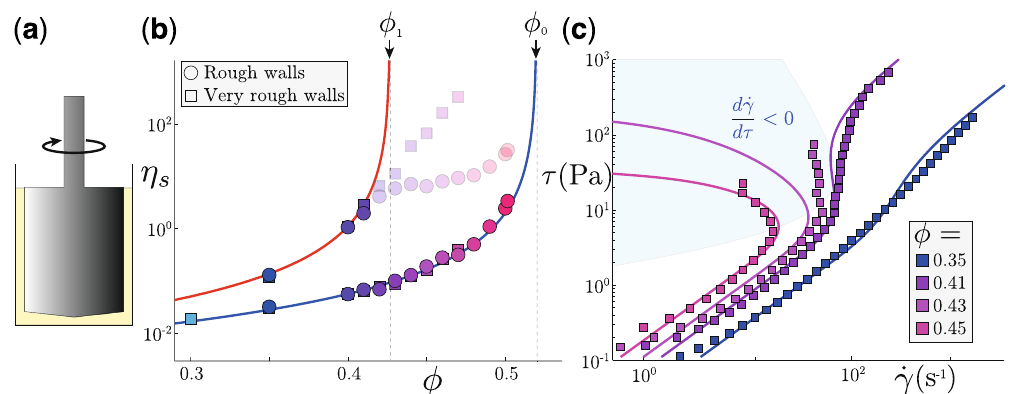
Fig. 5 Rheological data fi tting procedure. a Cylindrical-Couette geometry used to characterize the rheology of the aqueous suspension of cornstarch (yellow). The gray area represents the cylinder rotating in the direction indicated by the black arrow. b Viscosity (Pa.s) below ( τ ≪ τ * ) and above ( τ ≫ τ * ) the shear-thickening transition versus ϕ . Blue-solid-line: frictionless branch, red-solid-line: frictional branch, black-dashed-lines: jamming volume fractions for the frictionless and frictional branches de fi ning ϕ 0 and ϕ 1 , respectively. Square and circle symbols correspond to measurements performed with different wall roughness. The data points made transparent are not used in the fi tting procedure as for these points, the measurement depend on the wall roughness. c Shear stress τ versus shear rate _ γ measured at various volume fraction ϕ . Solid lines: Wyart & Cates rheological laws. The blue shaded area highlights the region where the rheograms are negatively sloped (d _ γ = d τ < Couette cell (Fig. 5a) using a rheometer (Anton Paar MCR 501). The height of the shear-cell (40 mm) is suf fi ciently large to neglect sedimentation effects of the particles during the measurement. Similarly to the procedure followed by Guy et al. 4 , the viscosity below ( τ ≪ τ * ) and above ( τ ≫ τ * ) the shear-thickening tran- sition are extracted and plotted versus ϕ (Fig. 5b). The low viscosity branch (frictionless branch) is fi rst fi tted with η ð ϕ Þ ¼ η s ð ϕ 0 (cid:3) ϕ Þ (cid:3) 2 , with η s and ϕ 0 as = 0.91± 0.01 mPa.s and ϕ = 0.52± 0.005. The fi tting parameters. This yields η s 0 large viscosity branch (frictional branch) is then fi tted with η ð ϕ Þ ¼ η s ð ϕ 1 (cid:3) ϕ Þ (cid:3) 2 , using the previous estimation of η s , and letting ϕ 1 as the only fi tting parameter.